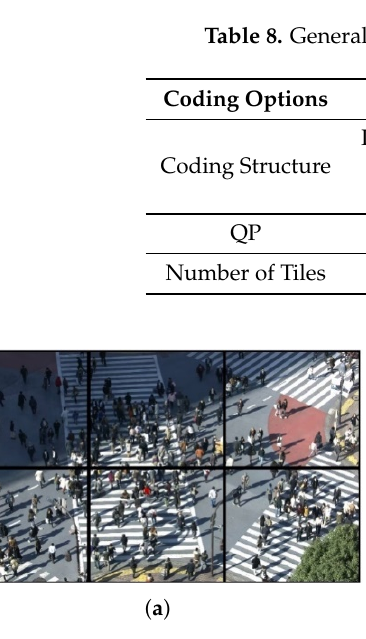
Figure 14. Tile partition of PeopleOnStreet test sequence with ( a ) conventional uniform tile partitioning, ( b ) Proposed non-uniform tile partitioning method considering Samsung Galaxy S7 Edge environments.